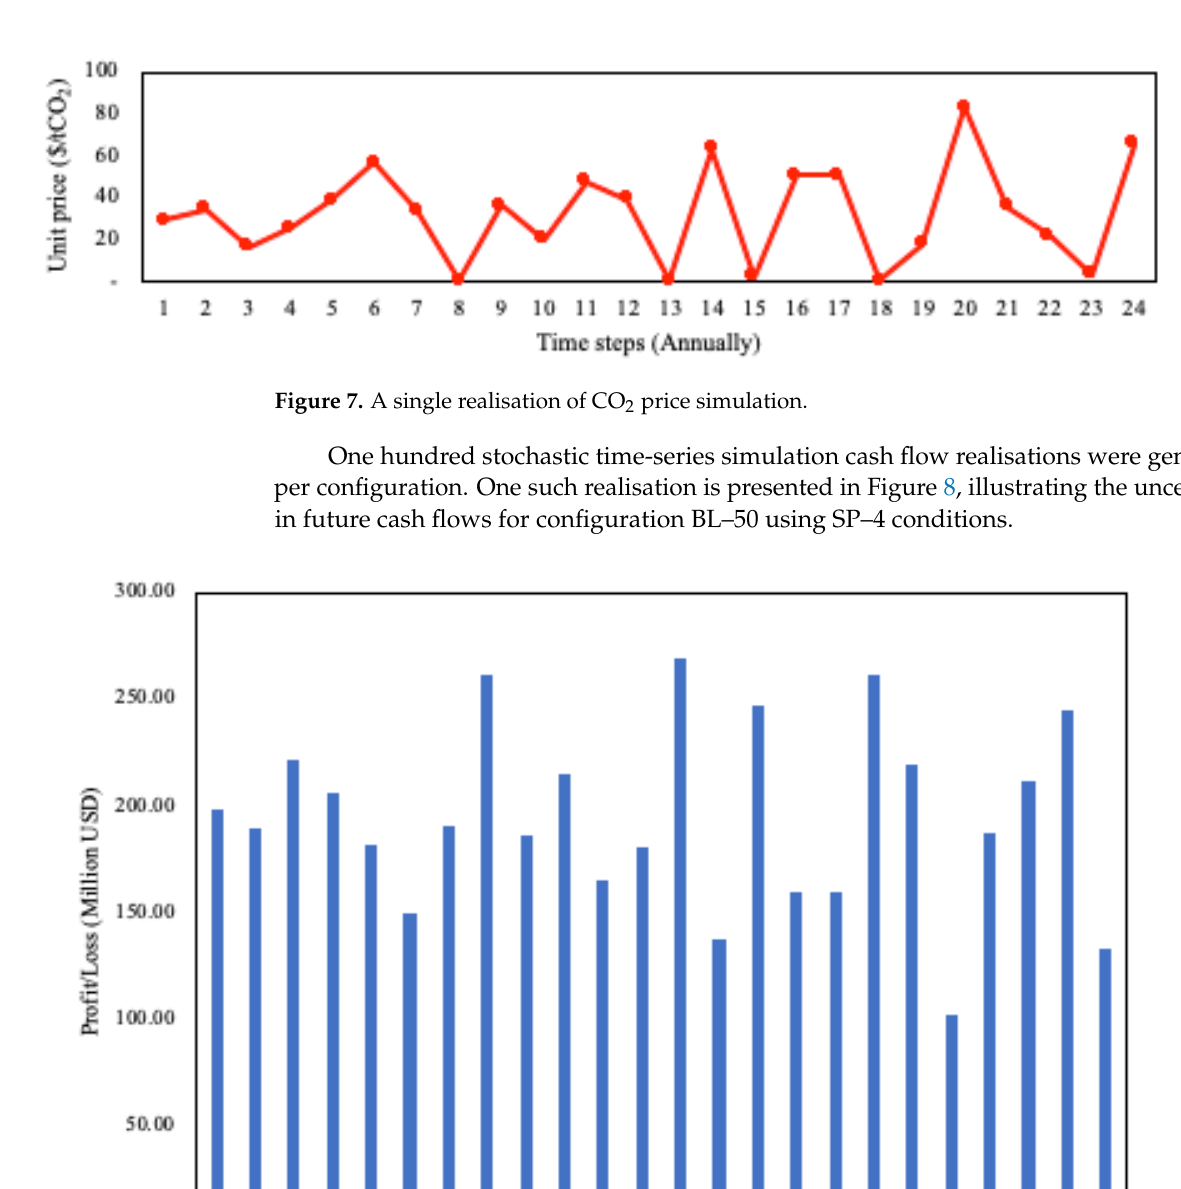
Figure 6. A single realisation of natural gas price simulation.